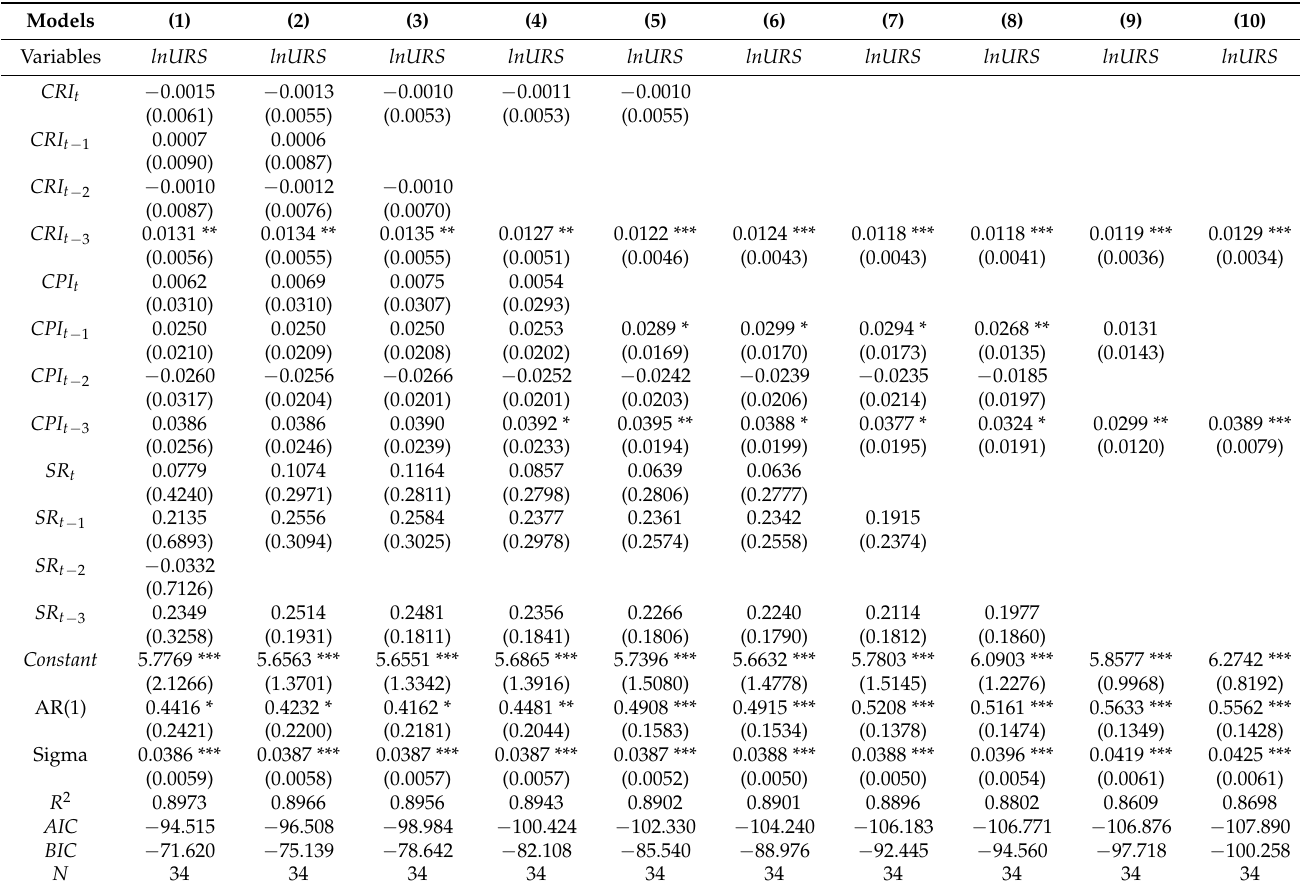
Table 3. Process and results of ARMAX model